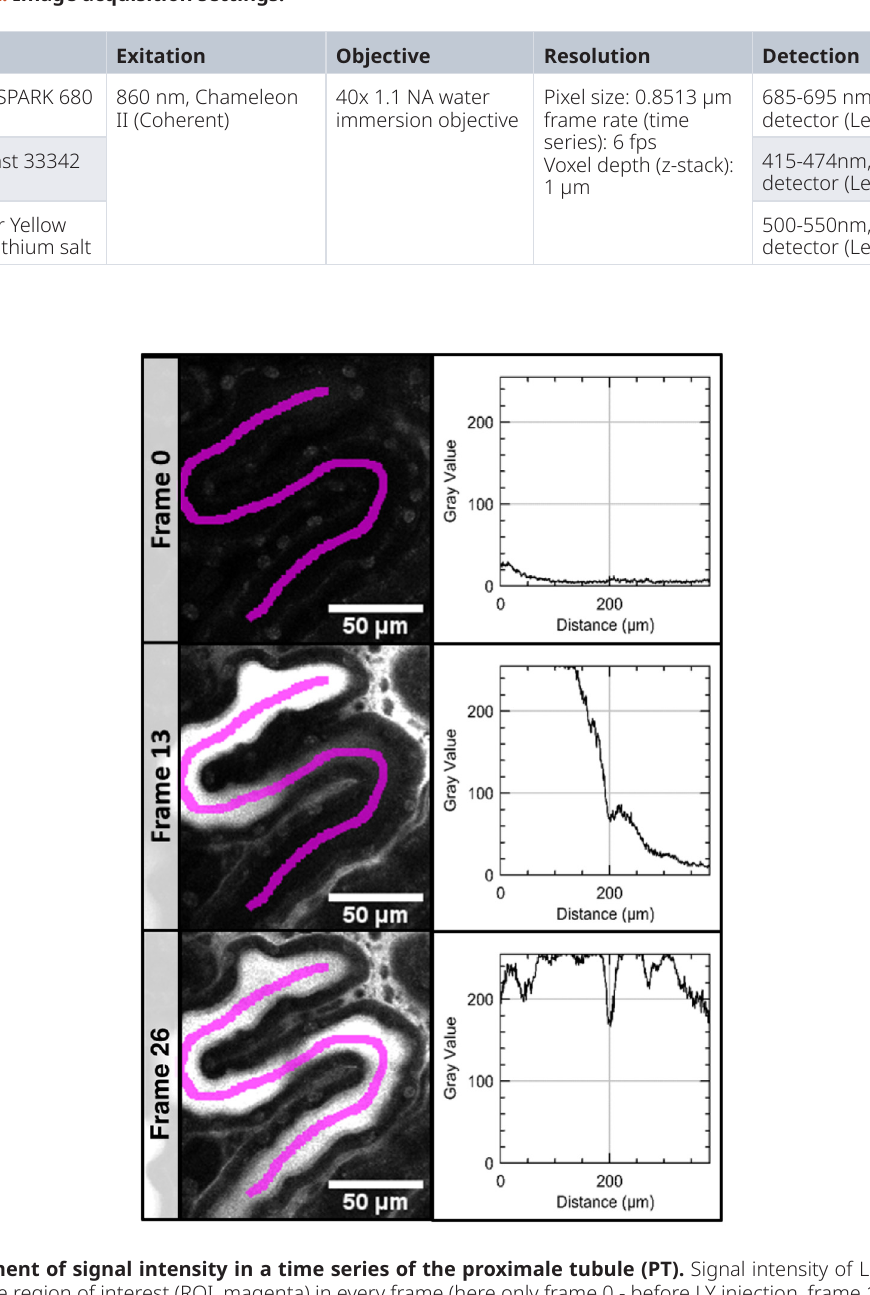
Figure 1. Measurement of signal intensity in a time series of the proximale tubule (PT). Signal intensity of LuciferYellow (LY) was measured along a line region of interest (ROI, magenta) in every frame (here only frame 0 - before LY injection, frame 13 and 26 are shown on the left). For visualization of the resulting data, the signal intensity along the ROI is plotted for these sample frames on the right. As the LY moves through the PT, the measured signal intensity shifts as